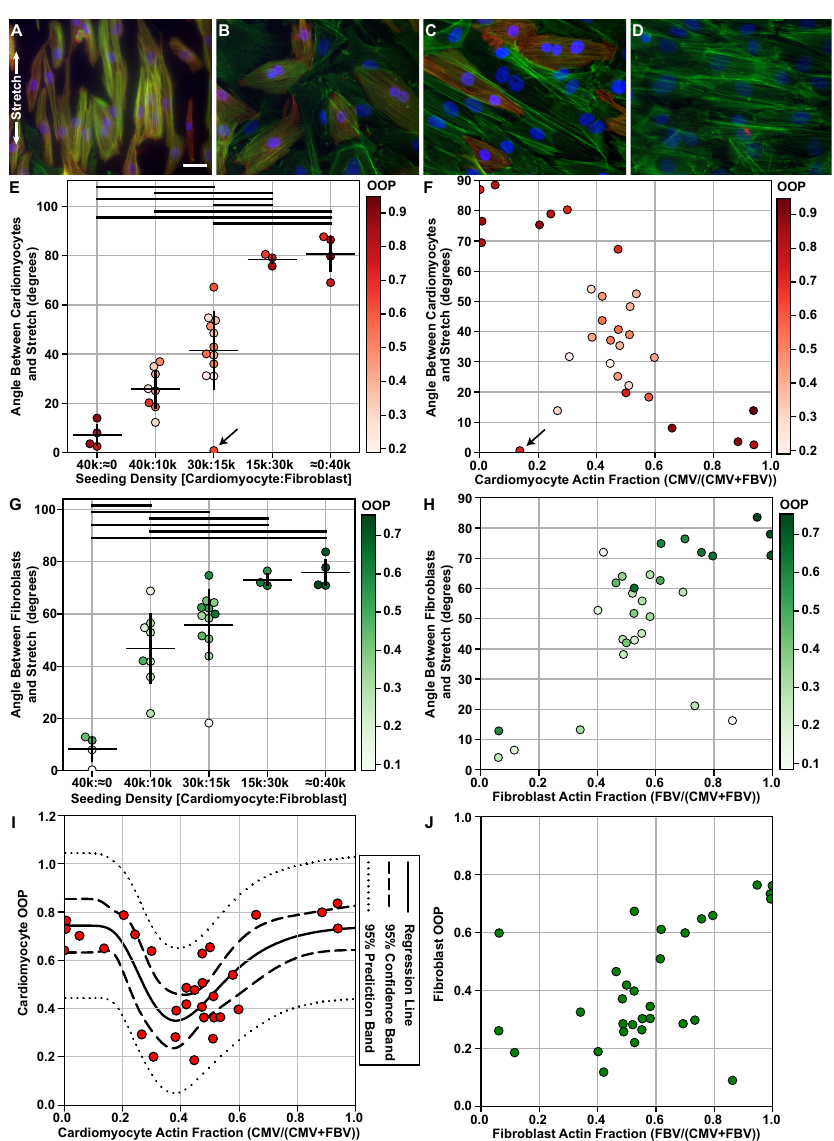
Figure 2. Cell type-specific actin orientation with respect to the direction of applied cyclic strain for different co-culture densities. Representative images of different experimental co-culture densities ( A ) 40k: ≈ 0 ( B ) 30k:15k ( C ) 15k:30k ( D ) ≈ 0:40k labeled with α -actinin (red), actin (green), and DAPI (blue). ( E ) The average and standard deviation of the angle between the cardiomyocyte actin director and stretch director for each experimental seeding density. ( F ) The angle between the cardiomyocyte actin director and stretch director for the measured cell type actin fraction, i.e., the total number of cardiomyocyte actin vectors divided by the total number actin vectors. ( G ) The average and standard deviation of the angle between the fibroblast actin director and stretch director for each experimental seeding density. ( H ) The angle between the fibroblast actin director and stretch director for the measured cell type actin fraction, i.e., the total number of fibroblast actin vectors divided by the total number actin vectors. ( I ) Cardiomyocyte OOP as a function of actin fraction; fitted with a log-normal equation ( p < 0.05); regression line (solid), 95% confidence interval (dashed), and 95% prediction band (dotted). ( J ) Fibroblast OOP as a function of actin fraction. In ( A , B ), the arrows indicate a well with sparser than expected density. In ( E – J ), each point represents a single well, which is colored by the actin OOP for cardiomyocytes ( E , F , I ) or fibroblasts ( G , H , J ). Sample sizes of each experimental condition can be found in Table A1. In ( E , G ), horizontal bars indicate groups with significantly different means ( p < 0.05). All scale bars: 25